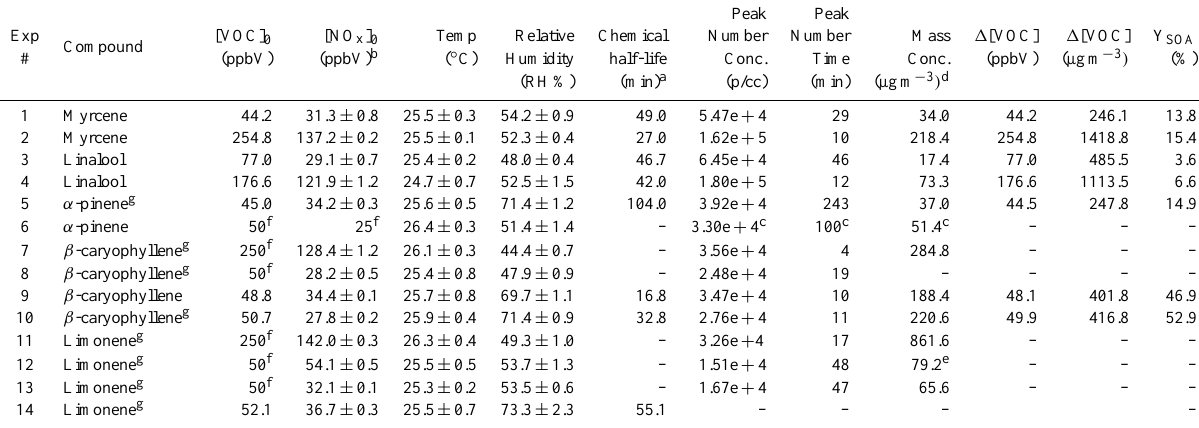
Table 1. Overview of initial experimental conditions and SOA formation characteristics.